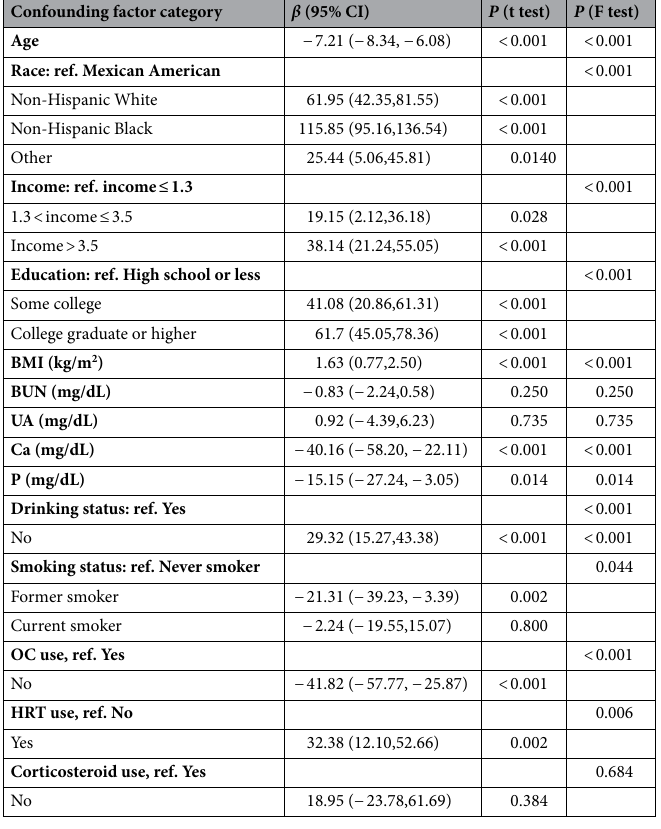
Table 2. Univariate linear regression analyses. Data presented are the β and 95% confidence interval (CI), β (θ 1 , θ 2 ). β is the effect size, θ 1 > 0 indicates a positive correlation (P < 0.05), θ 2 < 0 indicates a negative correlation (P < 0.05), and θ 1 < 0 < θ 2 indicates no correlation (P > 0.05).